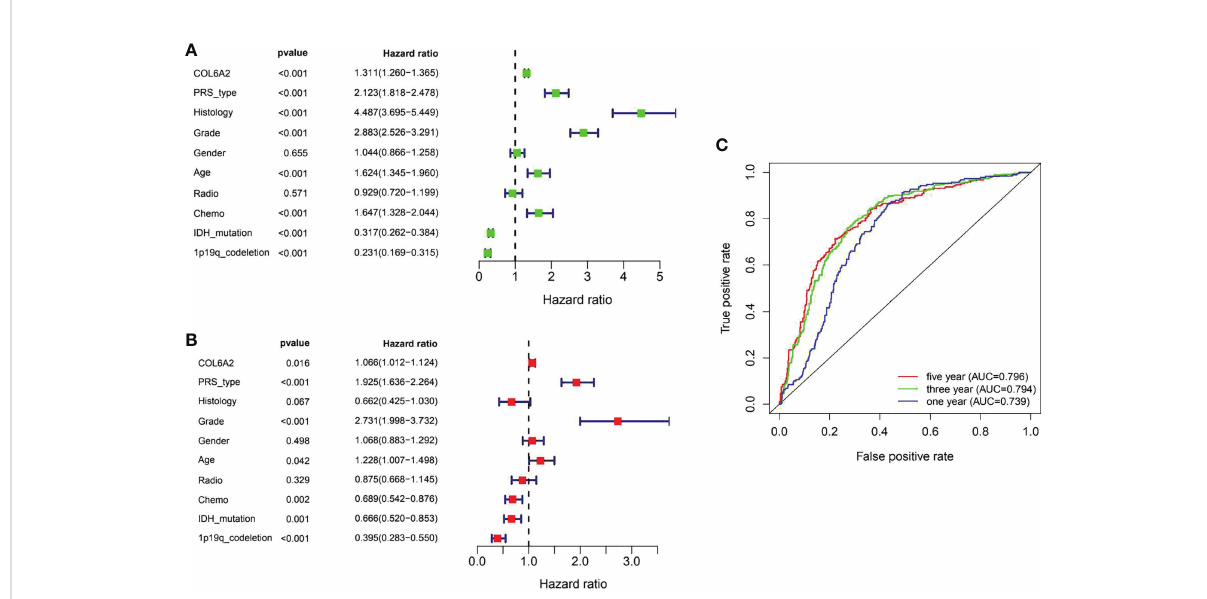
FIGURE 4 Evaluation of COL6A2 expression on the prognostic risk model of glioma patients in the CGGA. (A) Univariate analysis. (B) Multivariate Cox analyses. (C) The predictive accuracy of risk signature, fi ve-year AUC=0.796, three year AUC=0.794, one year